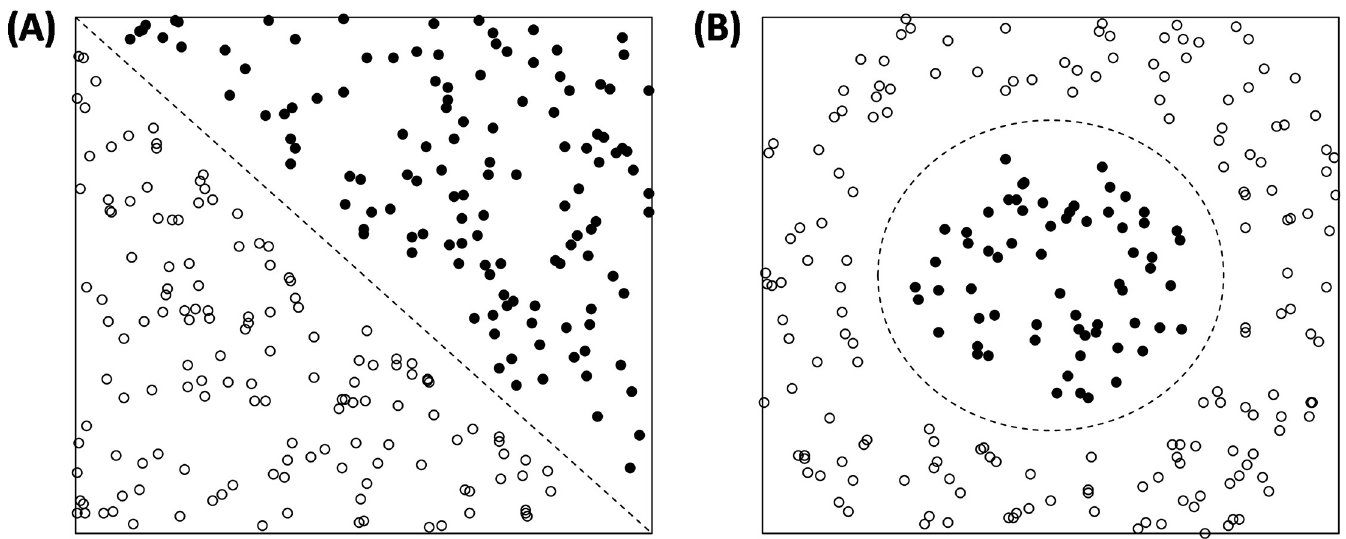
Fig 2. Linear and non-linear separability. (A) shows two classes of data that can be separated by a single straight line (i.e. they are ‘linearly separable’). (B) shows two classes of data that require a more complex classification topology (i.e. they are not linearly separable). Neural networks are capable of solving the complex topography in (B), whereas more traditional statistical methods (such as binary logistic regression, the obvious comparator in this case) are